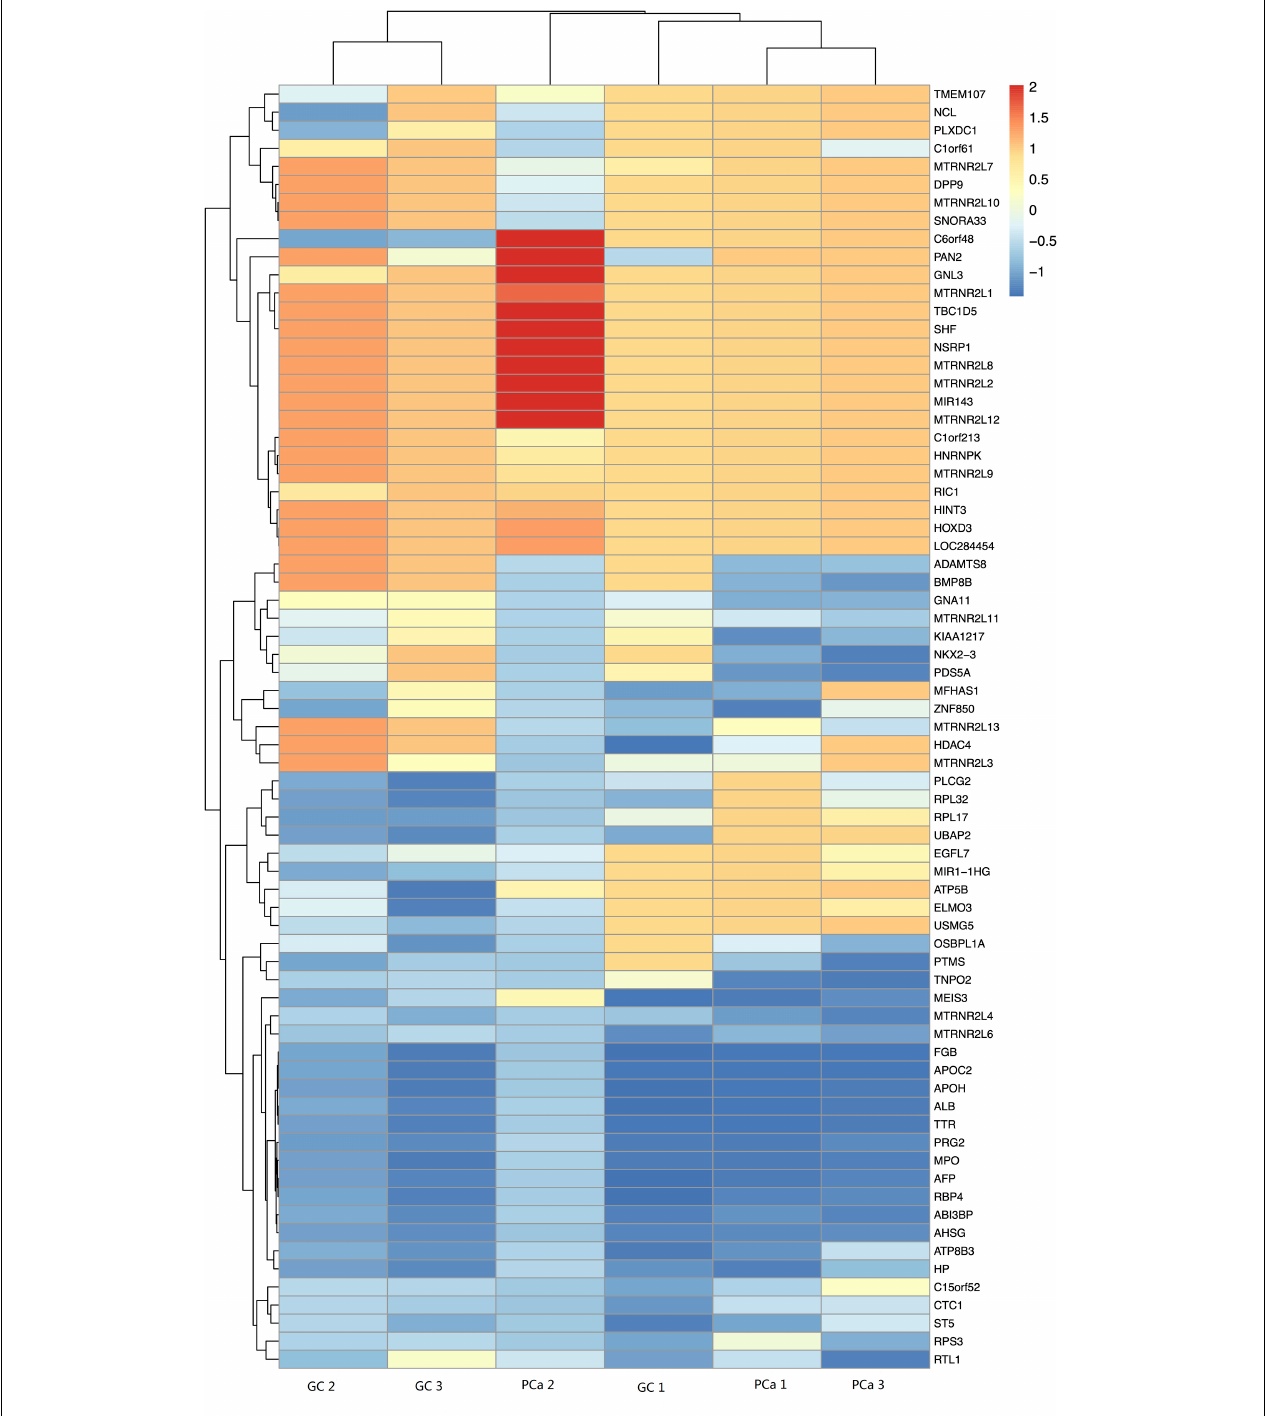
FIGURE 3 | The heatmap of intersecting m6A signals for the represent group.